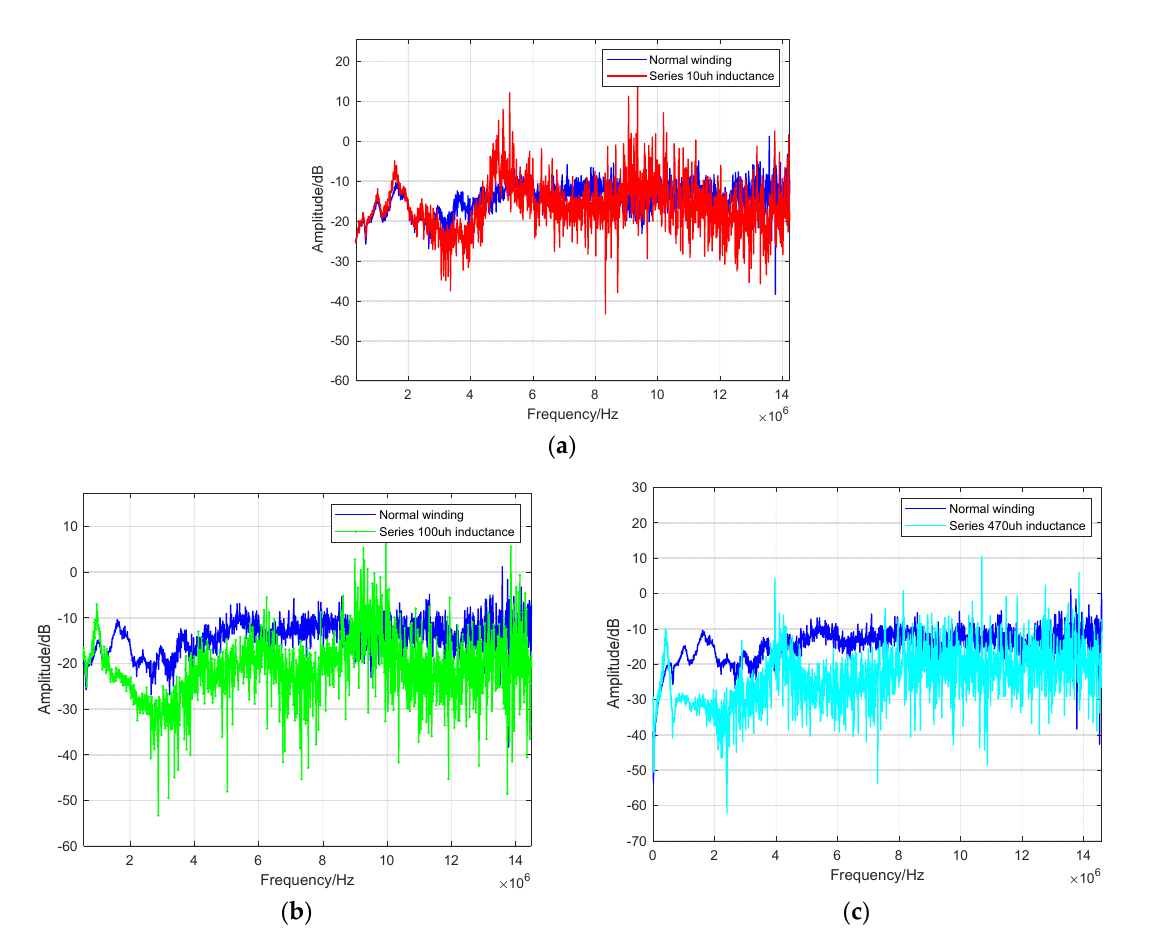
Figure 18. Experimental results. ( a ) Comparison between normal waveform and increased series inductance by 10 μ H; ( b ) Comparison between normal waveform and increased series inductance by 100 μ H; ( c ) Comparison between normal waveform and increased series inductance by 470 μ H.